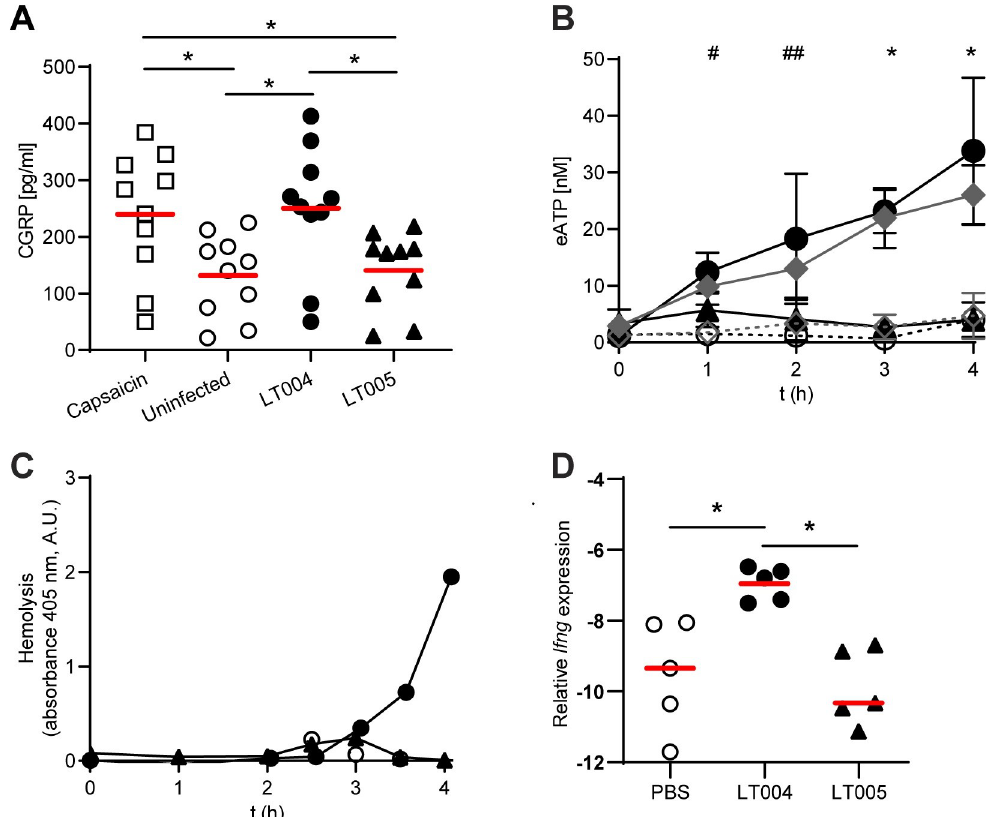
through media from renal epithelial A498 cells infected with CFT073 (HlyA+, black circles), LT002 (HlyA-, black triangles) and ARD371 (LT002 pBAD-HlyA+, grey diamonds), or uninfected (unfilled circles) and uninfected cells exposed to 0.2% arabinose (unfilled diamonds) under flow. Graph shows means ± SD, n = 3 for each condition. # = p < 0.05 of CFT073-infected compared to uninfected cells, ## = p < 0.05 of CFT073-infected compared to LT002-infected